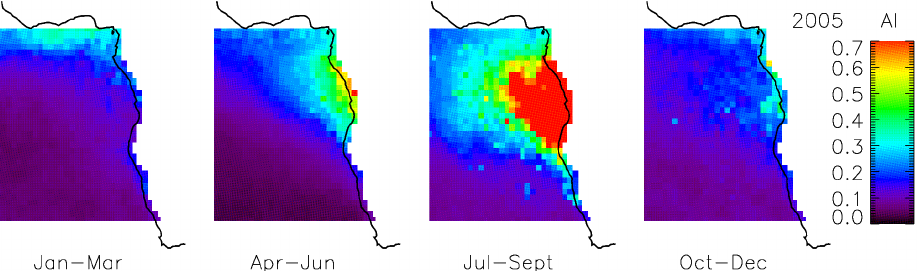
Fig. 3. Maps of seasonally averaged measurements of Aerosol Index (AI), for 2005. AI seasonal variability is high, but somewhat different from that of AOD, because aerosol composition and, hence, Angstrom exponent vary during the year.